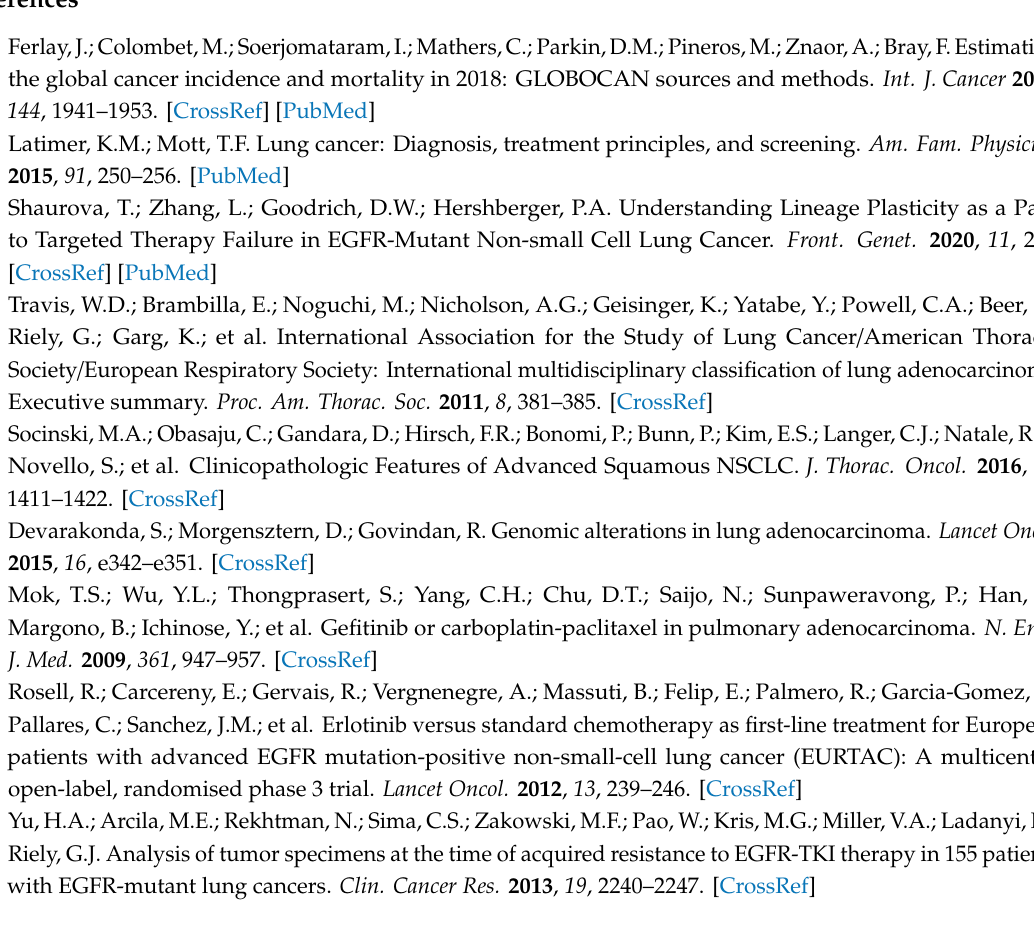
Figure S1. Human epidermal growth factor receptor (EGFR) bacterial artificial chromosome (BAC) constructs. Figure S2. Mouse Clara cell secretory protein (CCSP) bacterial artificial chromosome (BAC) construct, Figure S3. Polymerase chain reaction performed using tail DNA from wild type mice, [L858R] hEGFR and L858R / T790M hEGFR transgenic mice, Figure S4. Uncropped western blot